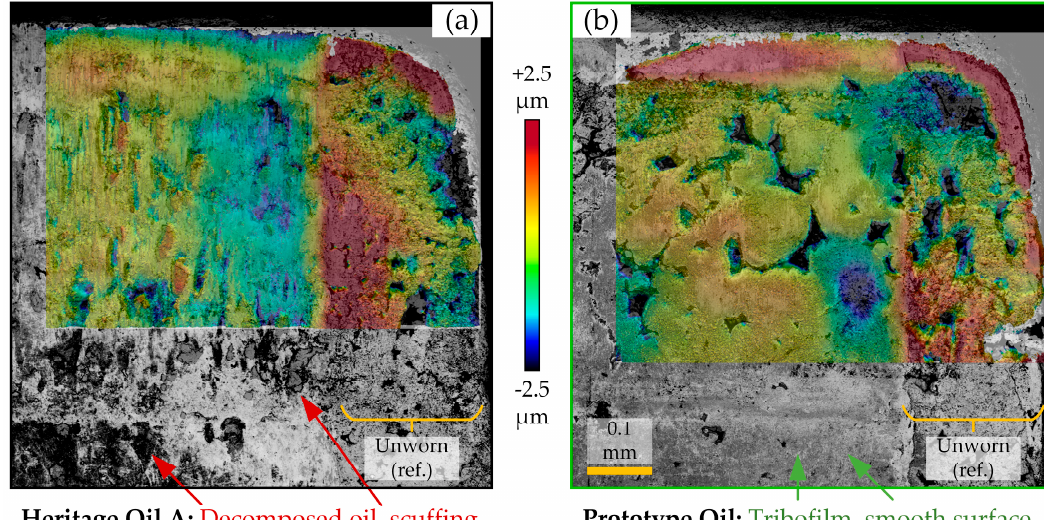
Figure 8. Oil starvation is indicated by the boundary lubrication phenomena observed in surface analysis by 3D-profilometry (3DP) and scanning electron microscopy (SEM). ( a ) Scuffing and decomposition of oil observed when lubricated with Heritage Oil A. ( b ) Tribofilm formation and smooth surface observed when lubricated with Prototype Oil.